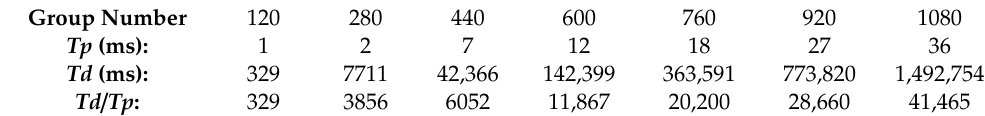
Table 1. Statistical results of time consumed by the two algorithms.